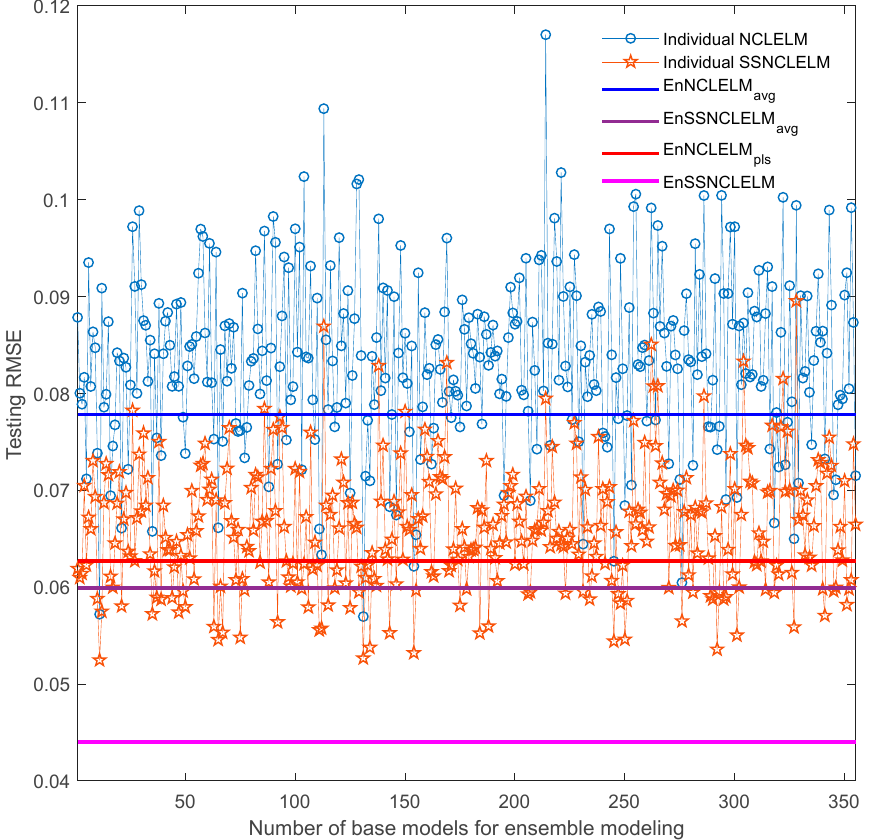
Figure 7. Prediction performance of individual models before and after incorporating semi-supervised learning.